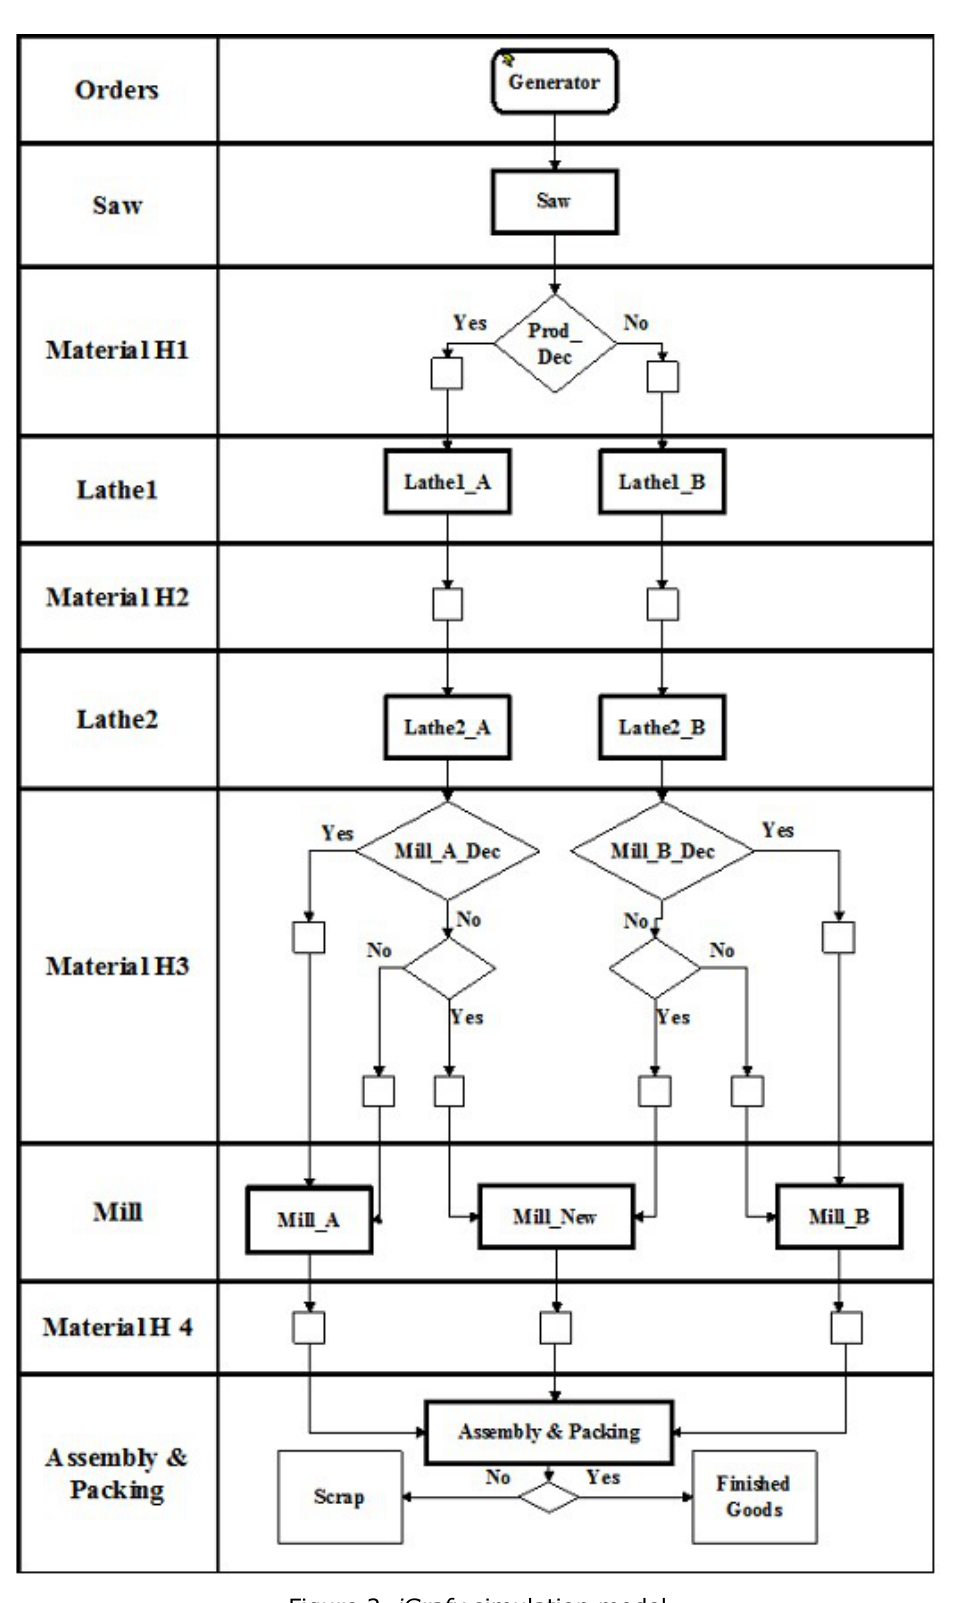
Figure 2. iGrafx simulation